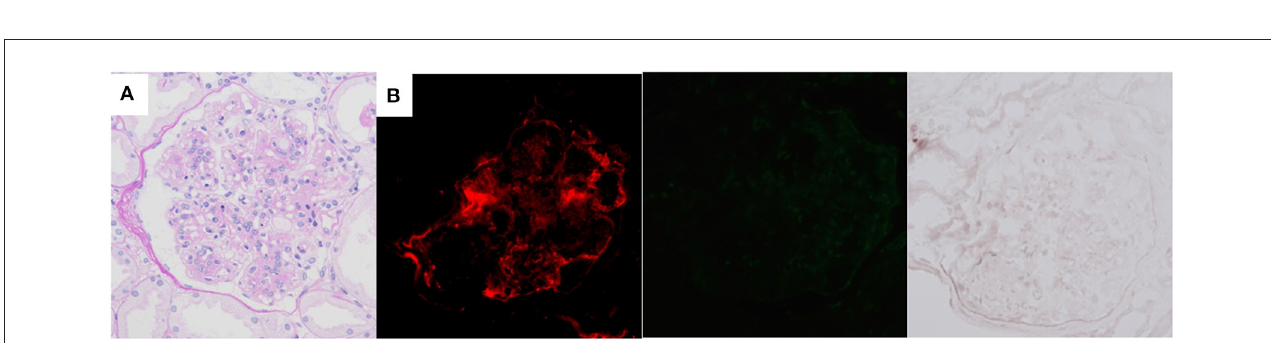
FIGURE3 Histological features of the second renal biopsy of case 2, performed about 3 years after the first. Mesangial proliferation and focal double contour of capillary walls are shown by light microscopy [ (A) periodic acid-Schiff stain]. Immunofluorescence staining for complement C3 is positive (left), but both nephritis-associated plasmin receptor (middle) and plasmin activity (right) are negative (B)